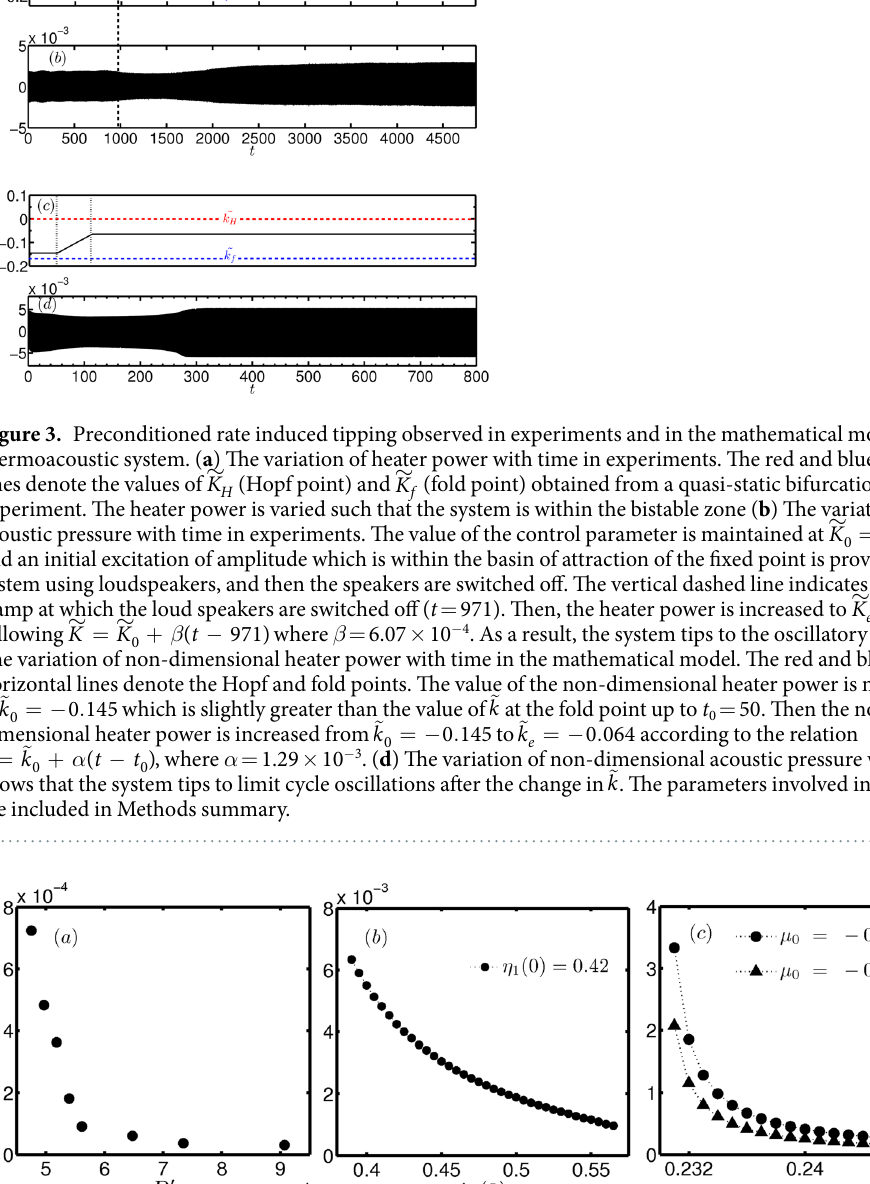
initial conditions in experiments, theoretical model and the normal form equation of subcritical Hopf bifurca- tion. We find that the critical rate required for tipping is small when the initial condition is closer to the unstable limit cycle. We can further notice that subcritical pitchfork bifurcation (with a fifth order nonlinear term) will have the same critical rate for tipping as in the case of subcritical Hopf bifurcation. Thus, we illustrate that precon- ditioned rate induced tipping can potentially be observed in a wide range of systems exhibiting subcritical Hopf and subcritical pitchfork bifurcations.